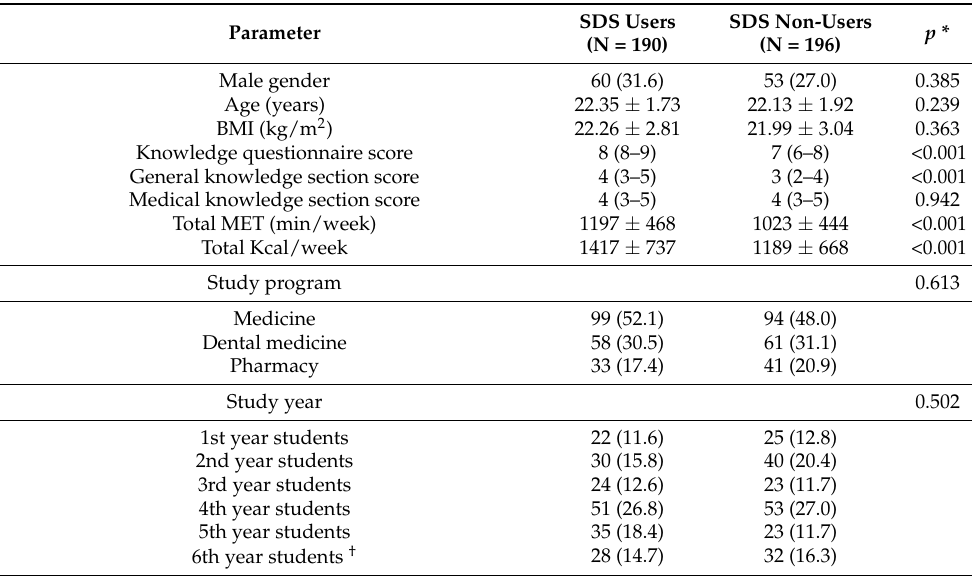
Table 6. Comparison between SDS users and